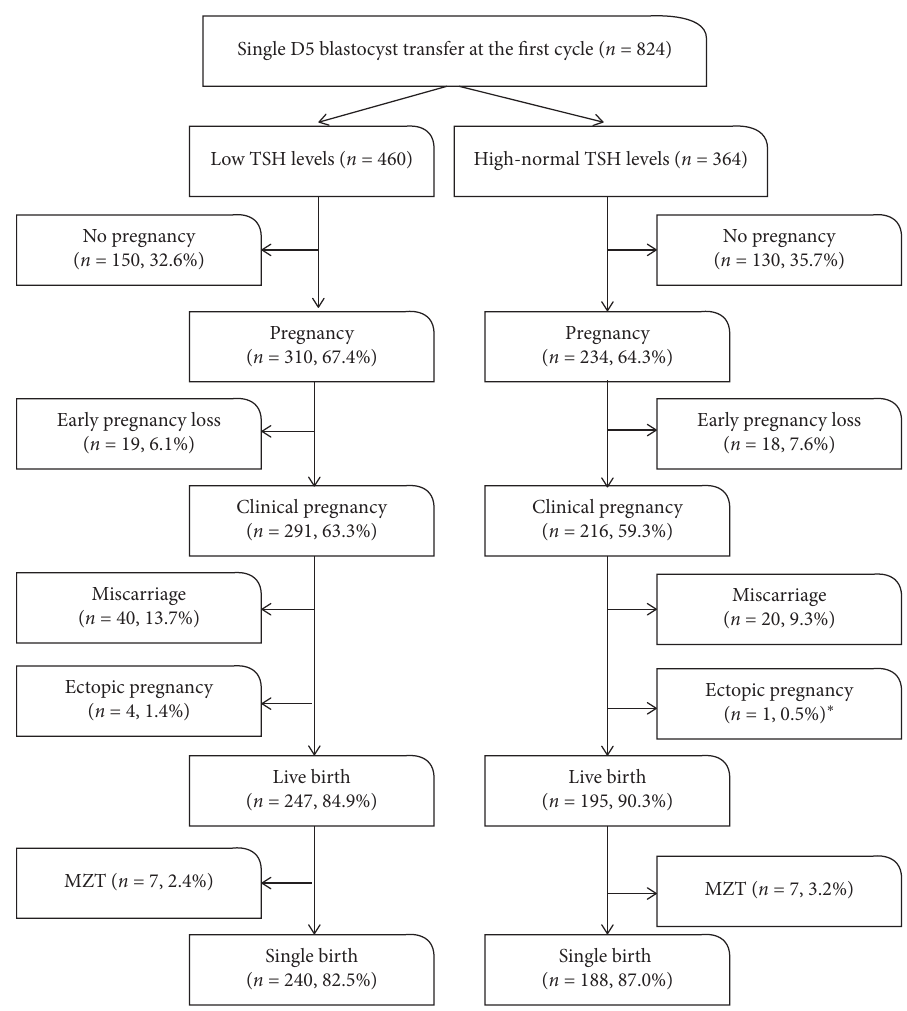
Figure 2: Clinical outcomes after the first single D5 blastocyst transfer. ∗ Fisher’s exact test was Table 3: The impact of preconception high-normal TSH levels on clinical outcomes.